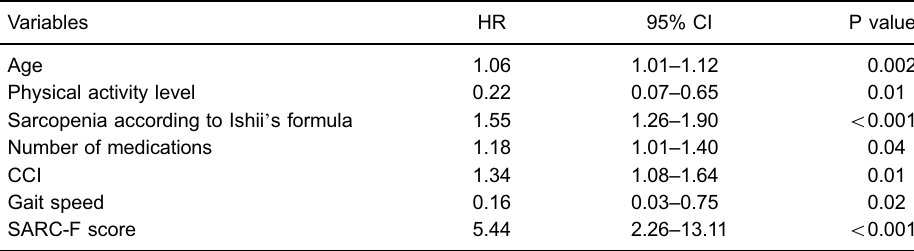
Table 2. Results of univariate Cox proportional hazard analysis for rehospitalization.